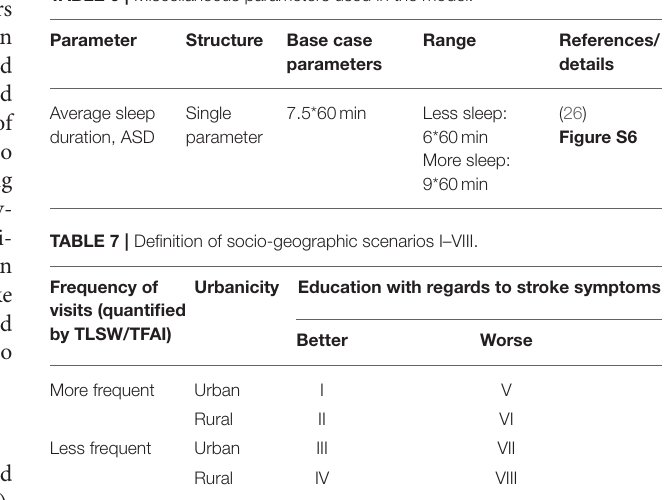
TABLE 6 | Miscellaneous parameters used in the model.